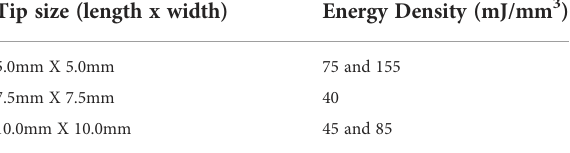
TABLE 1 Energies applied for each tip size.